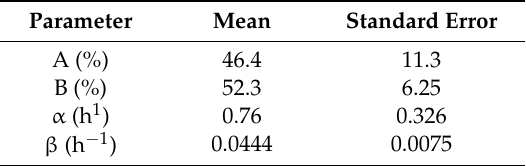
Table 4. Fitted model